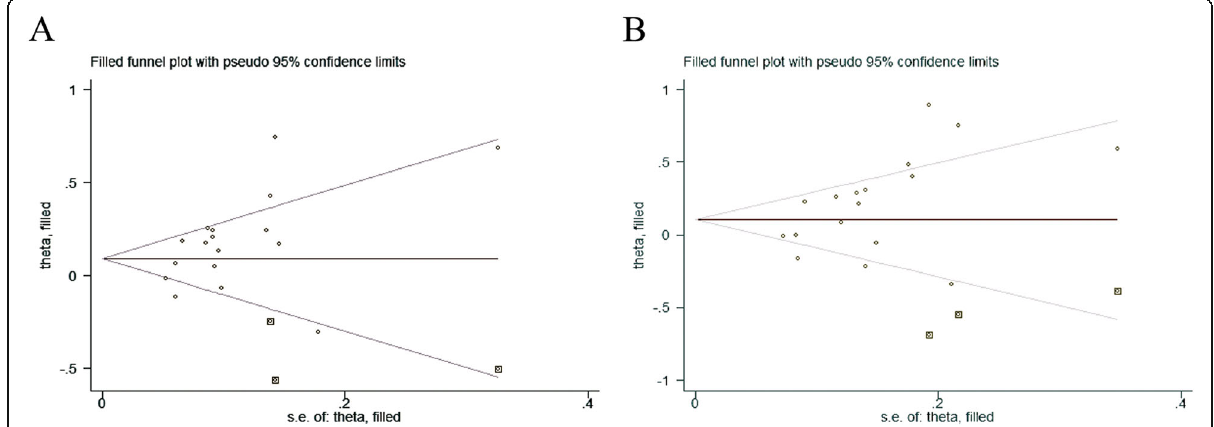
Fig. 5 Trim and fill method ’ s funnel plot of the association between H19 rs217727 polymorphism and cancer risk. a Allelic model (T vs. C), b dominant model [(CT + TT) vs.